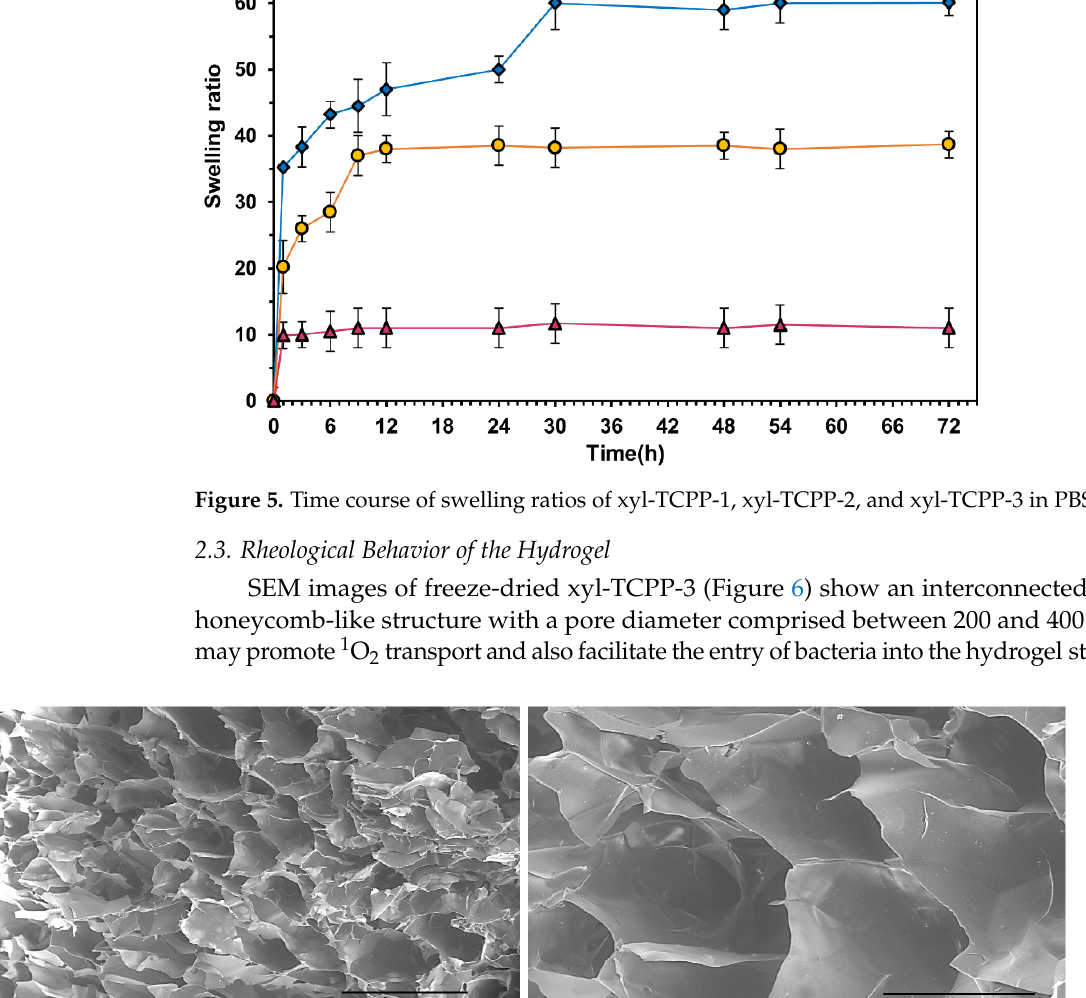
Figure 6. SEM images of cross sections of lyophilized xyl- TCPP-3.